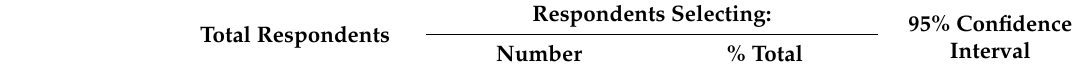
Table 8. The impact of ME—Perceived level of disability.